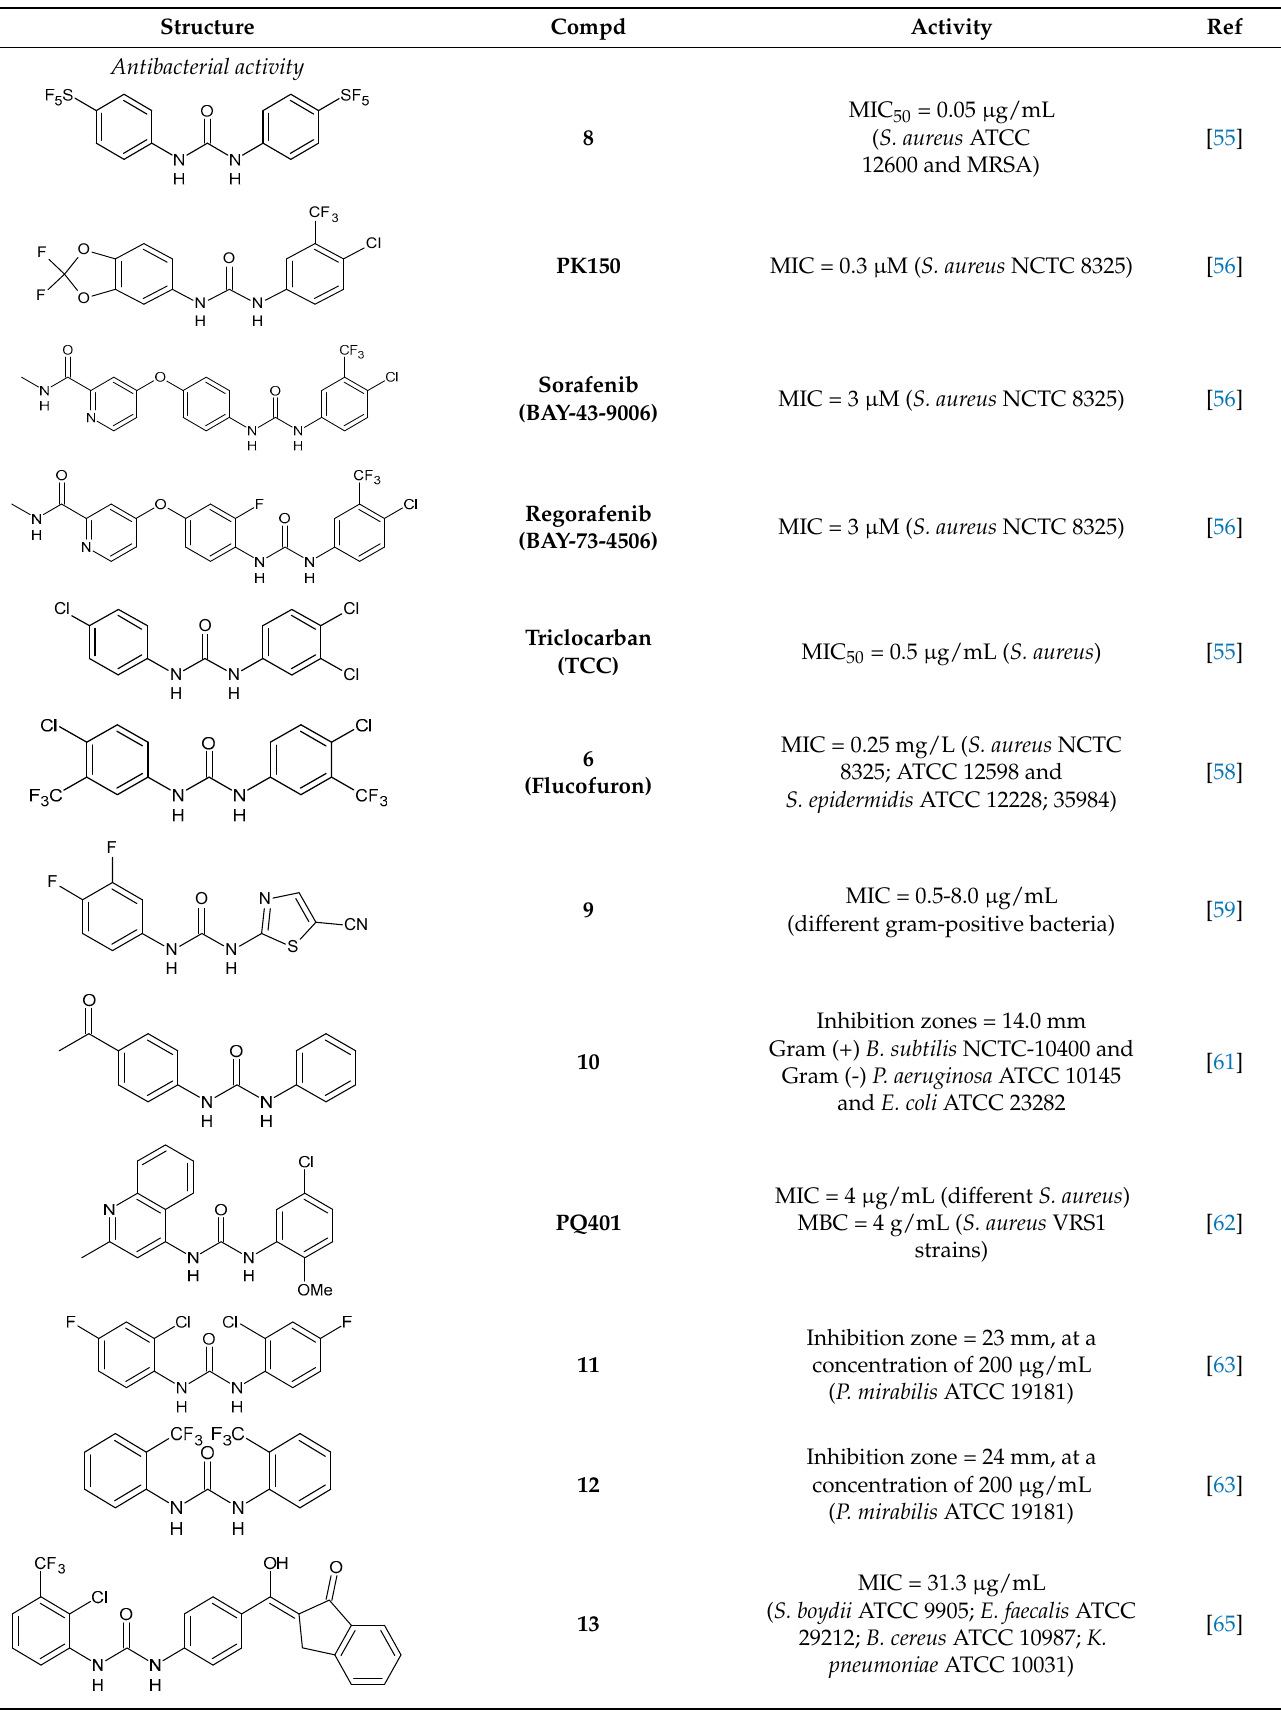
Table 2. Diarylureas as antibacterials and antifungals.